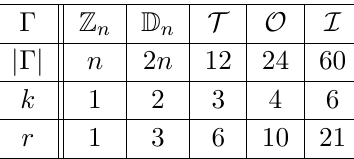
Table 1. Orbifolds of S 2 { Γ for finite groups Γ (cid:128) SO p 3 q of order | Γ | , listed with their corresponding relative order of scale separation r , and the lowest degree k for which there is a Γ -invariant spherical harmonic on S 2 . The explicit form of the invariants is given in section 2. None of these orbifolds admits Killing spinors; all of them contain singular points.